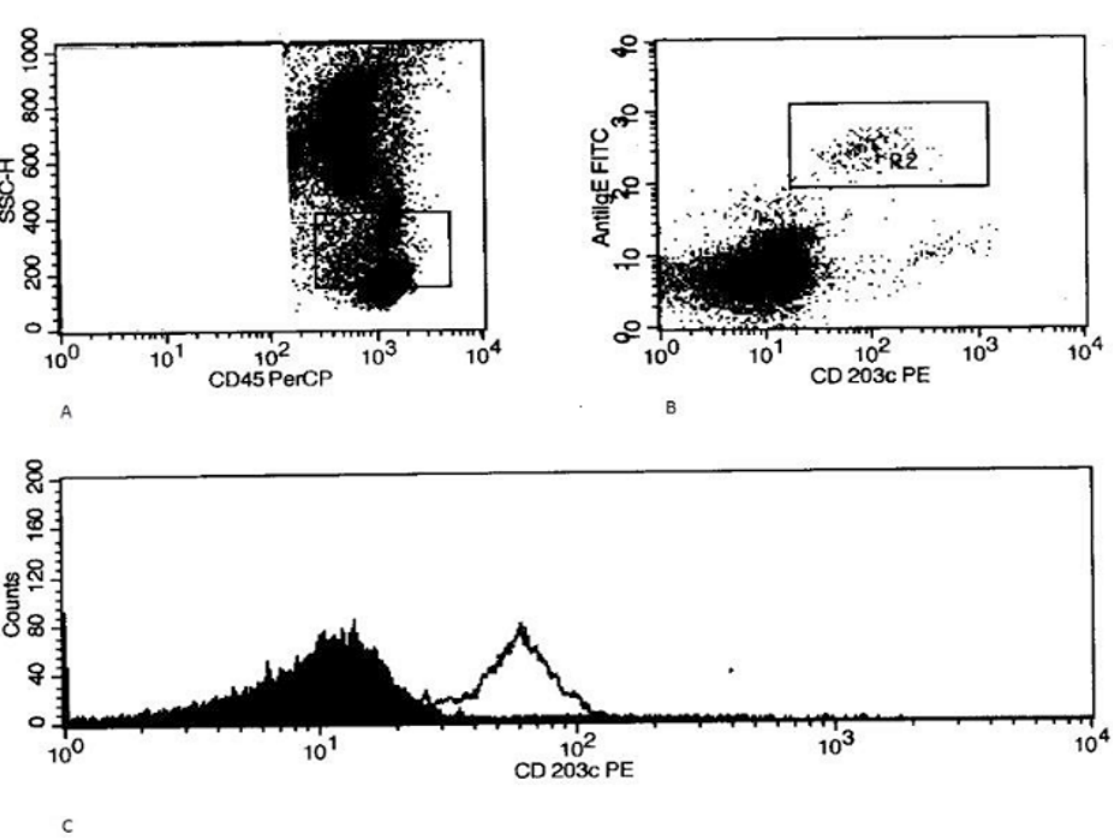
Figure 2. Basophil identification and expression of CD203c. Basophils located between the monocytes and lymphocytes were gated with R1 and R2 (boxed area). Gate R1 (A) isolates the side scatter and CD45+ basophils population. Gate R2 (B) detects a population of cells highly positive for IgE and CD203c expression. Histograme of CD203c expression after addition of buffer (shaded area) and after addition of serum of patient with CU and positive ASST.